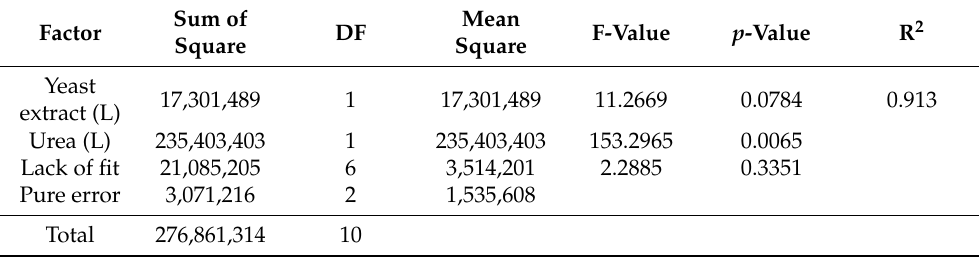
Table 3. Analysis of variance (ANOVA) for the central composite rotatable design for extracellular lipase production by Y. lipolytica cultivated in Erlenmeyer flask for 16 h with pomegranate-seed residue (PSR) supplemented with yeast extract and